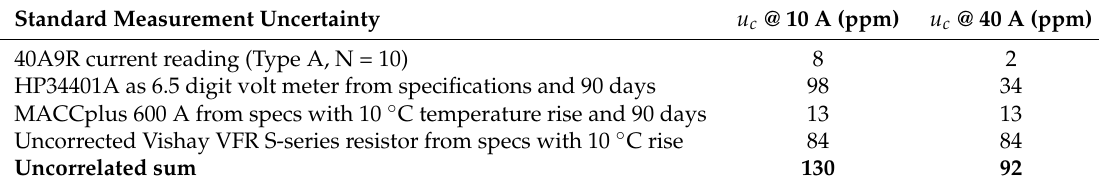
Table 2. Measurement uncertainty evaluated at 10 and 40 A of primary current, and k = 1. Standard Measurement